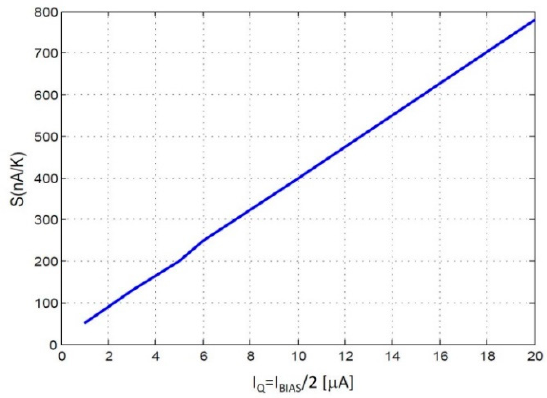
Figure 9. Thermal transconductance of the lateral PNP transistors, S BJT , in function of the DC current set by I BIAS .